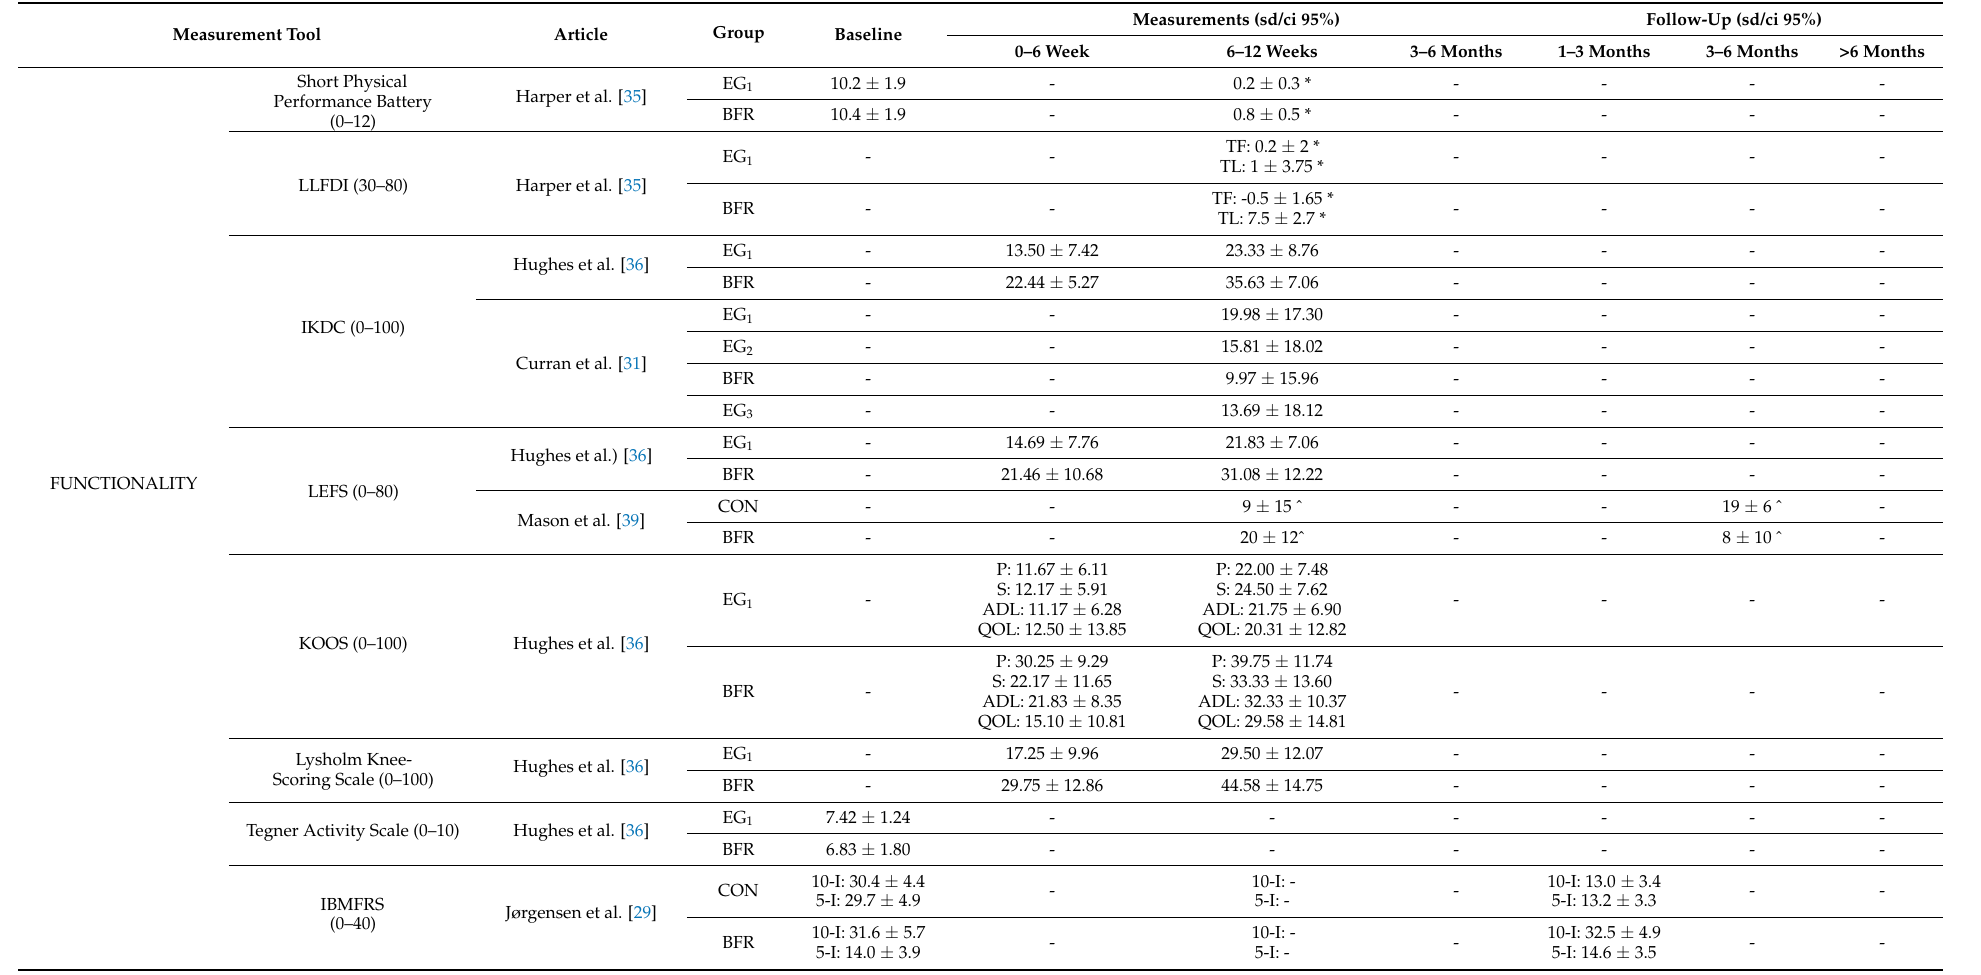
Table 4. Functionality (subjective outcomes) analyzed in the short-, medium-, and long-term, both during the intervention period and in a follow-up that could be longer than 6 months after the end of the